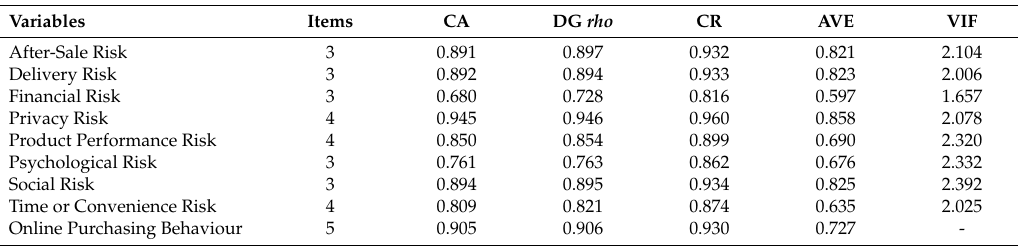
Table 4. Reliability